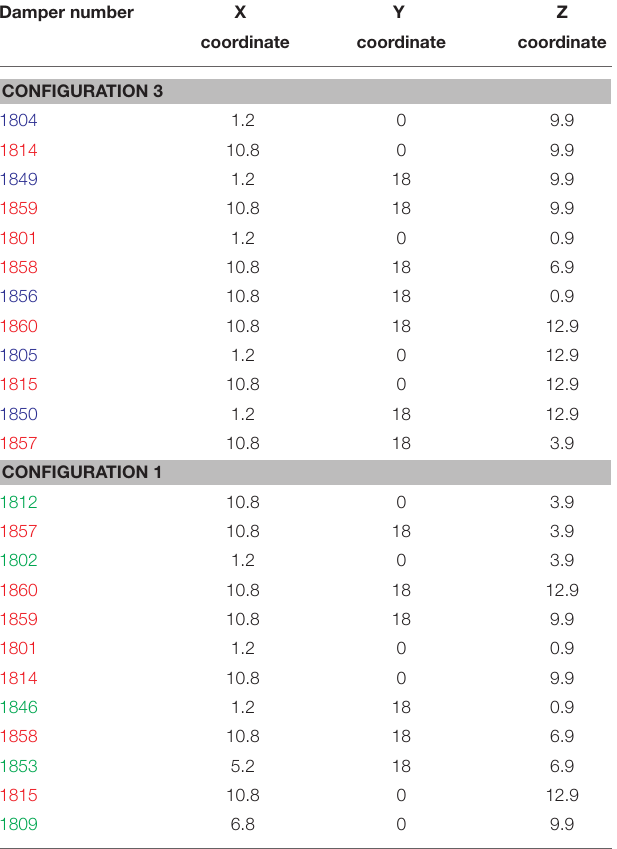
TABLE 6 | Third generation dampers in X and Y direction-third configuration.